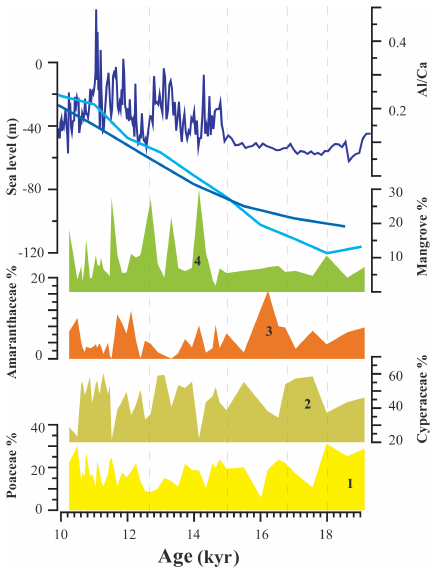
Figure 6. Comparison of the pollen record from marine core GeoB12624-1 with sea-level reconstructions: dark blue from Wael- broeck et al. (2002) and light blue from Rohling et al. (2009). Pollen percentages of Poaceae, Cyperaceae and Amaranthaceae indicate the succession of salt marshes (steps 1 to 3) and the mangrove for- est (step 4) along the Rufiji Delta. Dashed lines denote the four steps of the directional alternation of those